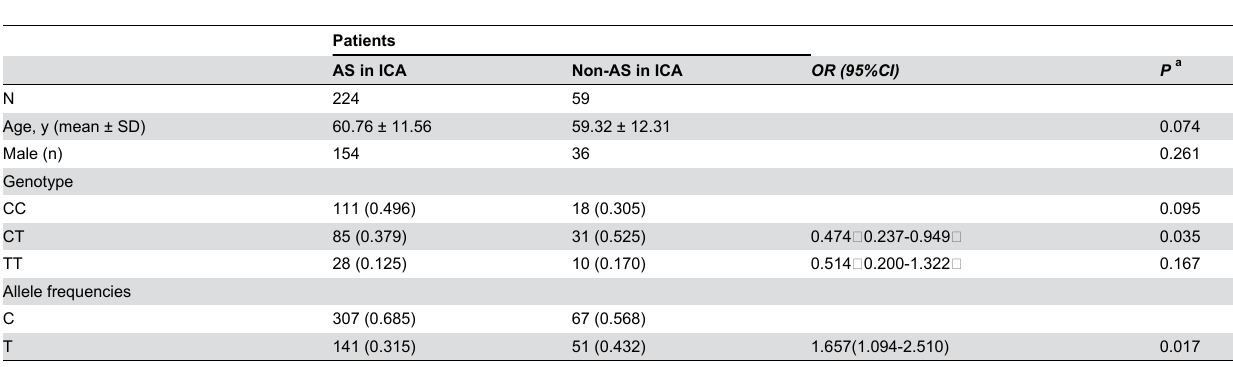
Table 3. Association of 781C/T polymorphism with AS of ICA in patients.